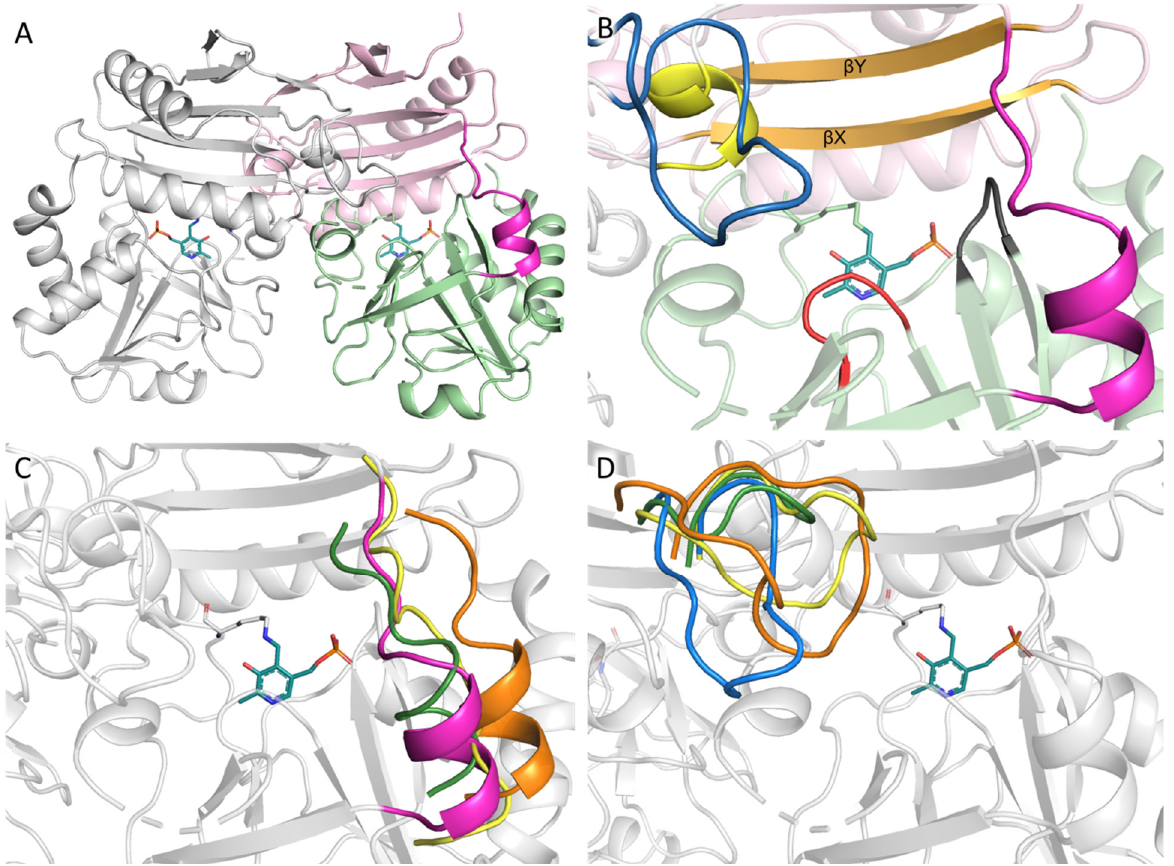
Figure 3. The overall structure of AmicoTA. ( A ) The two subunits in the AmicoTA dimer. In the right subunit, the small domain is shown in light pink, the large domain in light green, the interdomain loop in magenta, and the adjacent subunit in gray. The PLP molecules are shown in sticks. ( B ) The active site of AmicoTA. The important structural elements are shown: β X- and β Y-strands (orange), the O-pocket loop from the adjacent subunit (blue), the O-pocket α -helix from the adjacent subunit (yellow), β -turn1 (red), β -turn2 (black). ( C , D ) Alignment of the interdomain loops ( C ) and the O-pocket loops ( D ) of AmicoTA (O-pocket loop—blue, interdomain loop—magenta), bsDAAT (orange), CpuTA (green) and Halhy (yellow).